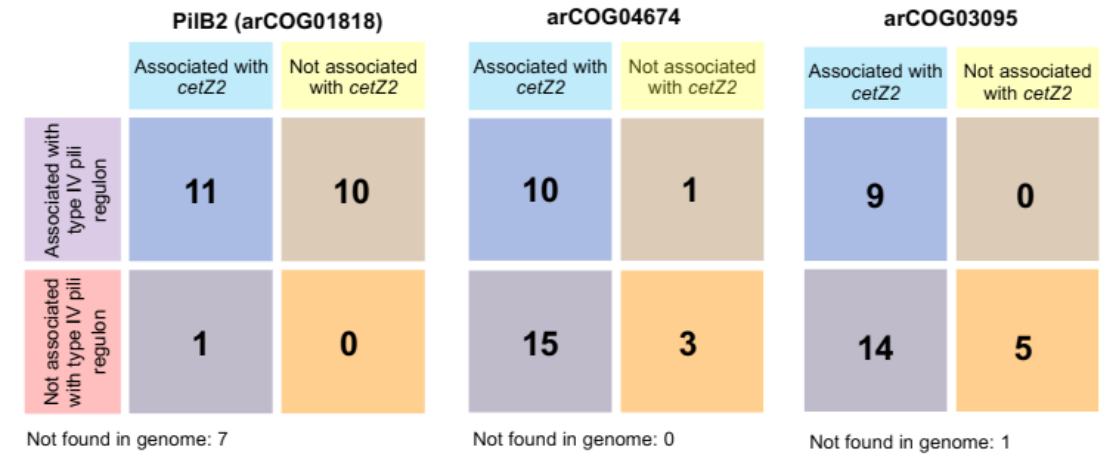
Figure 7. Synteny of cetZ2 with type IV system components pilB2 (arCOG01818), arCOG04674, and arCOG03095. arCOGs were classified as ‘associated with cetZ2 ’ if found within 20 kb either side of the cetZ2 gene. arCOGs ’associated with a type IV pili regulon’ were defined as those found within or adjacent to other arCOGs identified in the H. volcanii pilB2/C2 regulon. Species-specific data are provided in Figure